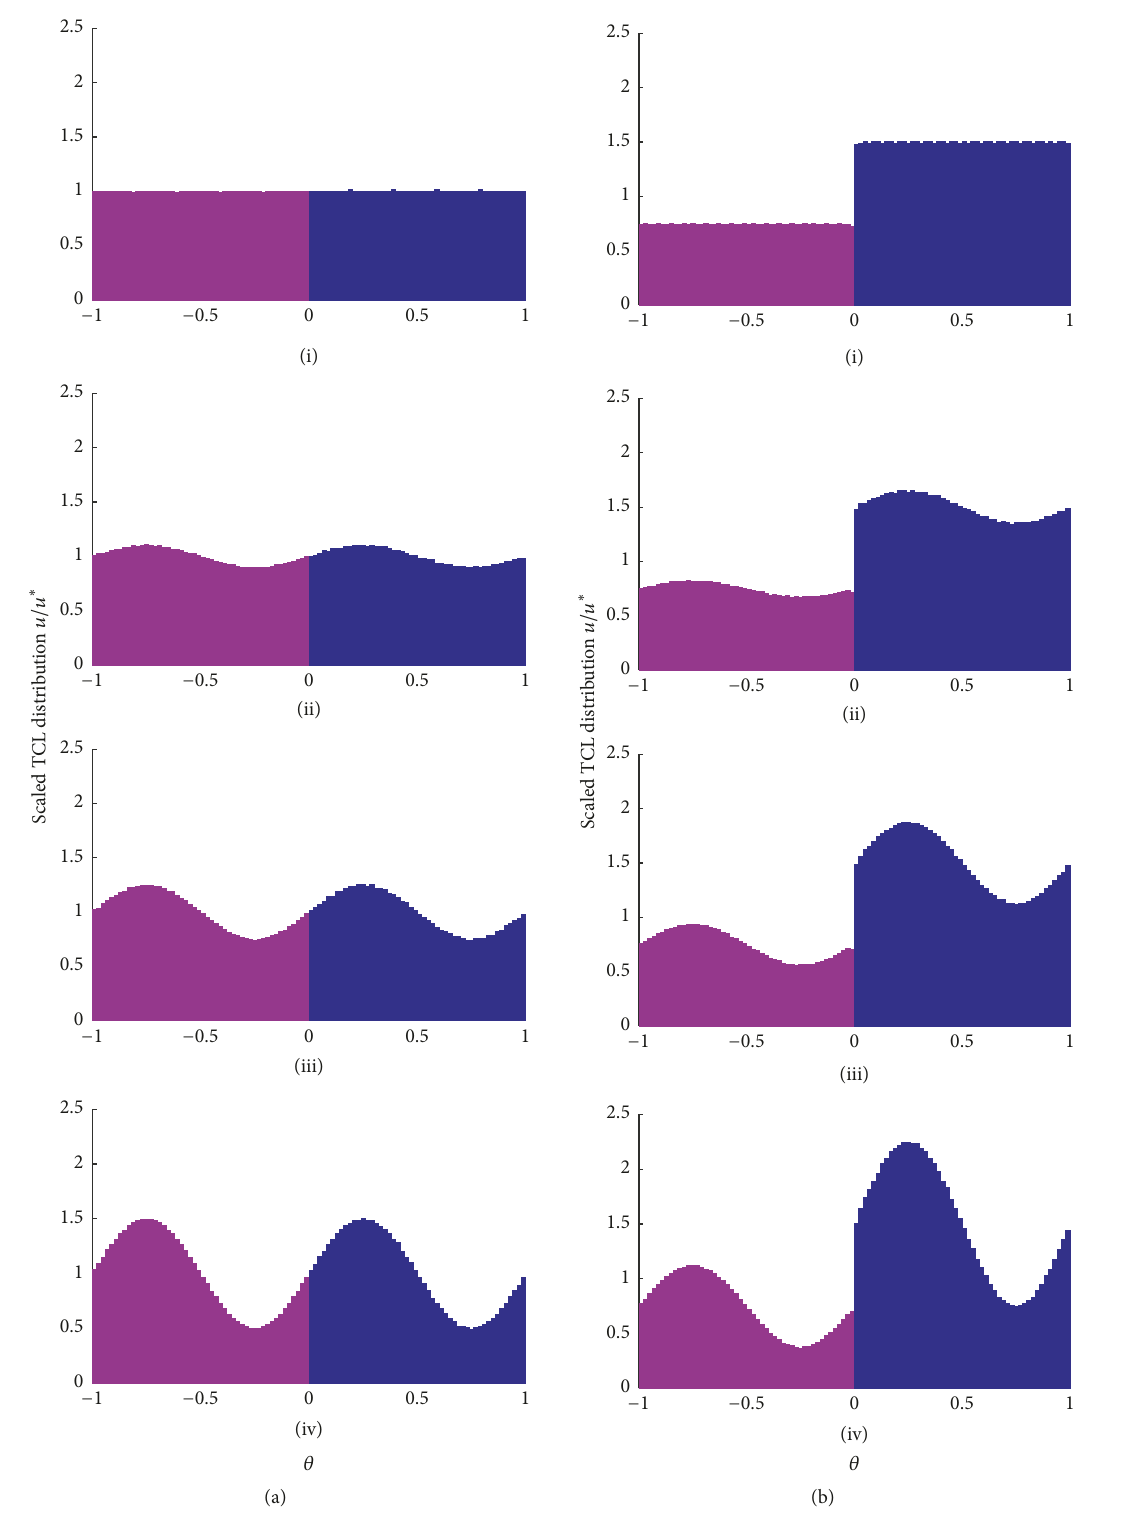
Figure 8: Initial fridge distributions in 𝜃 -space, with labels matching those in Table 3. Pink indicates switched off fridges, and blue indicates switched on. Distributions scaled by 1/𝑢 ∗ and histograms formed of 100 bins. (a) has no perturbation to the proportion of fridges switched on, and (b) has increasing perturbation (going downwards) to the number of fridges switched on. All involve sinusoidal distribution